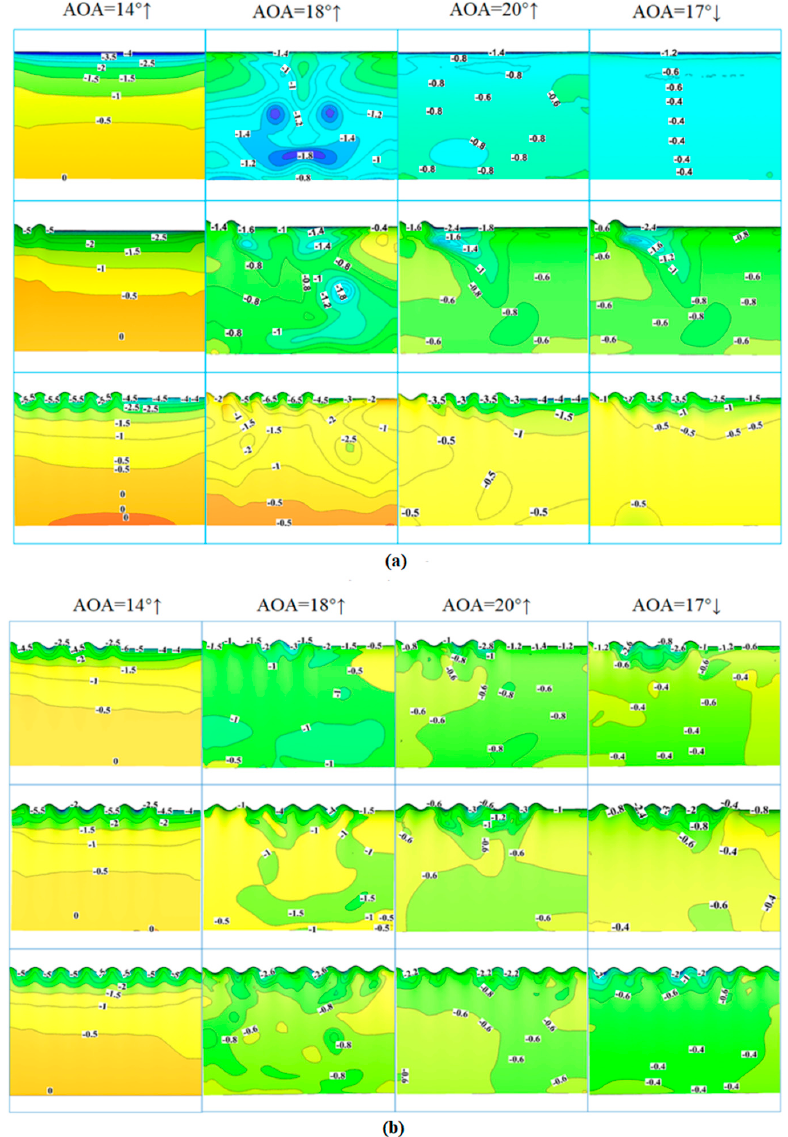
Figure 16. Pressure coefficients for different airfoils. ( a ) Baseline, R = 0.2, R = 0.4; ( b ) R = 0.6, R = 0.8, R = 1.0